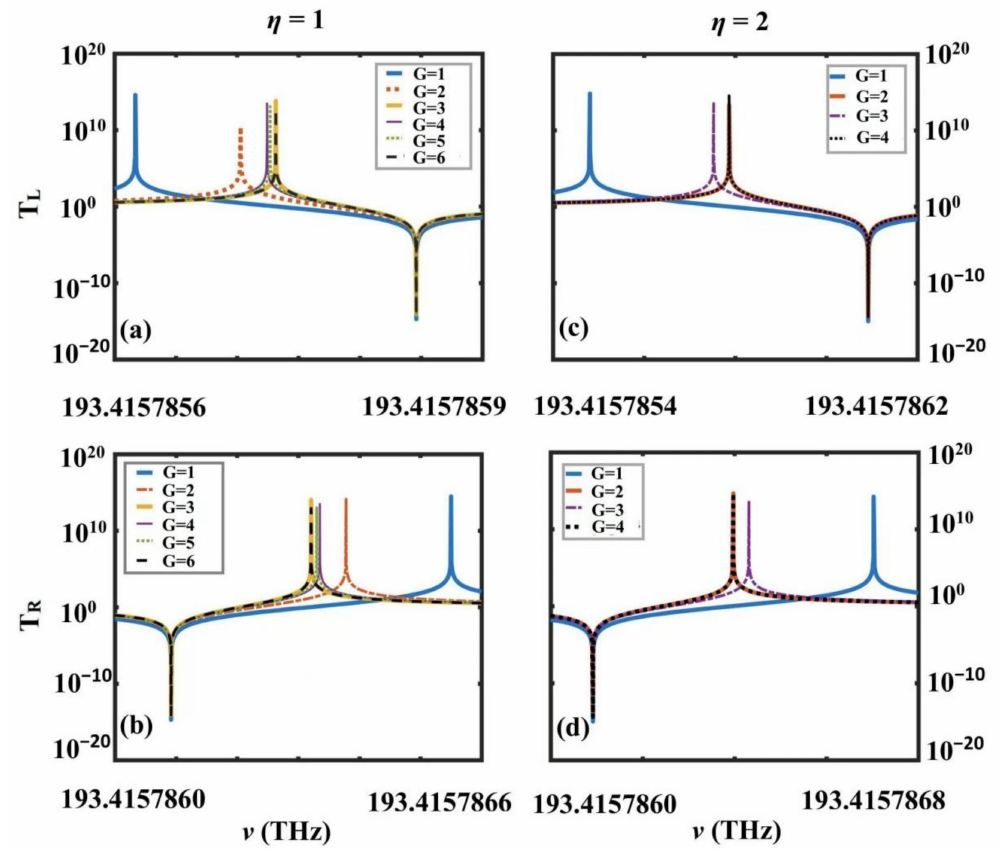
Figure 6. Transmission spectra of 1D PTSPROWN of η ( η = 1,2 ) , decided by the first extremum spontaneous PT-symmetric breaking point in two change periods of G : ( a , b ) η = 1, G = 1–6; ( c , d ), G =